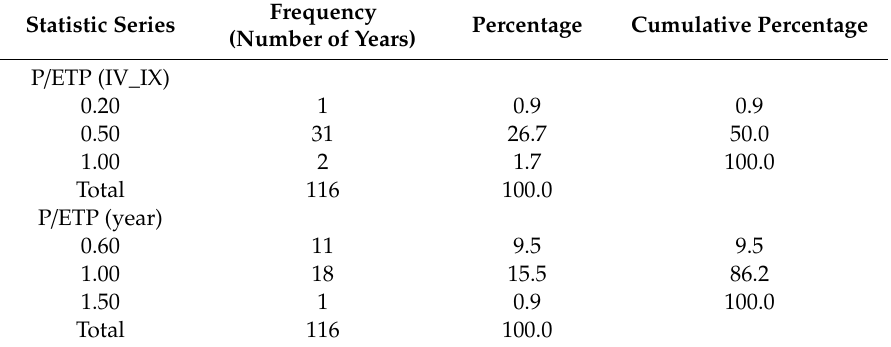
Table 3. Frequency of certain values regarding the ratio of accumulated precipitation in the warm period, between April and September (P / ETP IV_IX), respectively, throughout the year (P / ETP year), with evapotranspiration, recorded annually at the Regional Meteorological Center Banat-Crisana, Romania, 1898–2019. Frequency Statistic Series (Number of